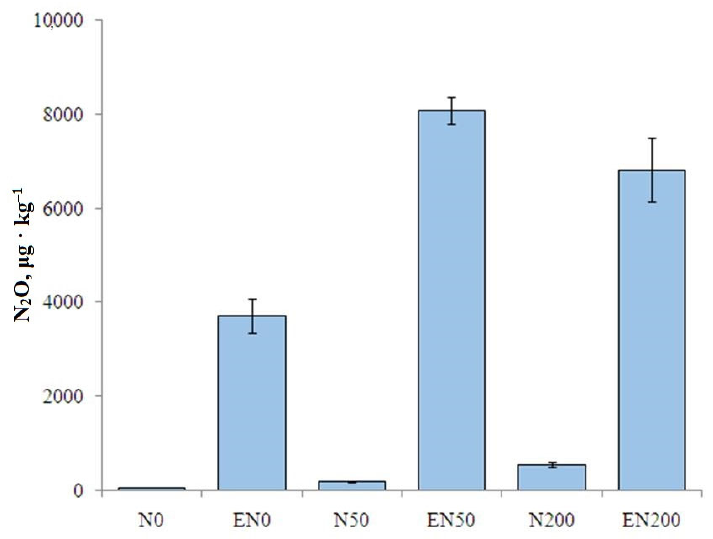
Figure 2. Cumulative 30 ‐ day emission of N 2 O ( μ g kg − 1 ).